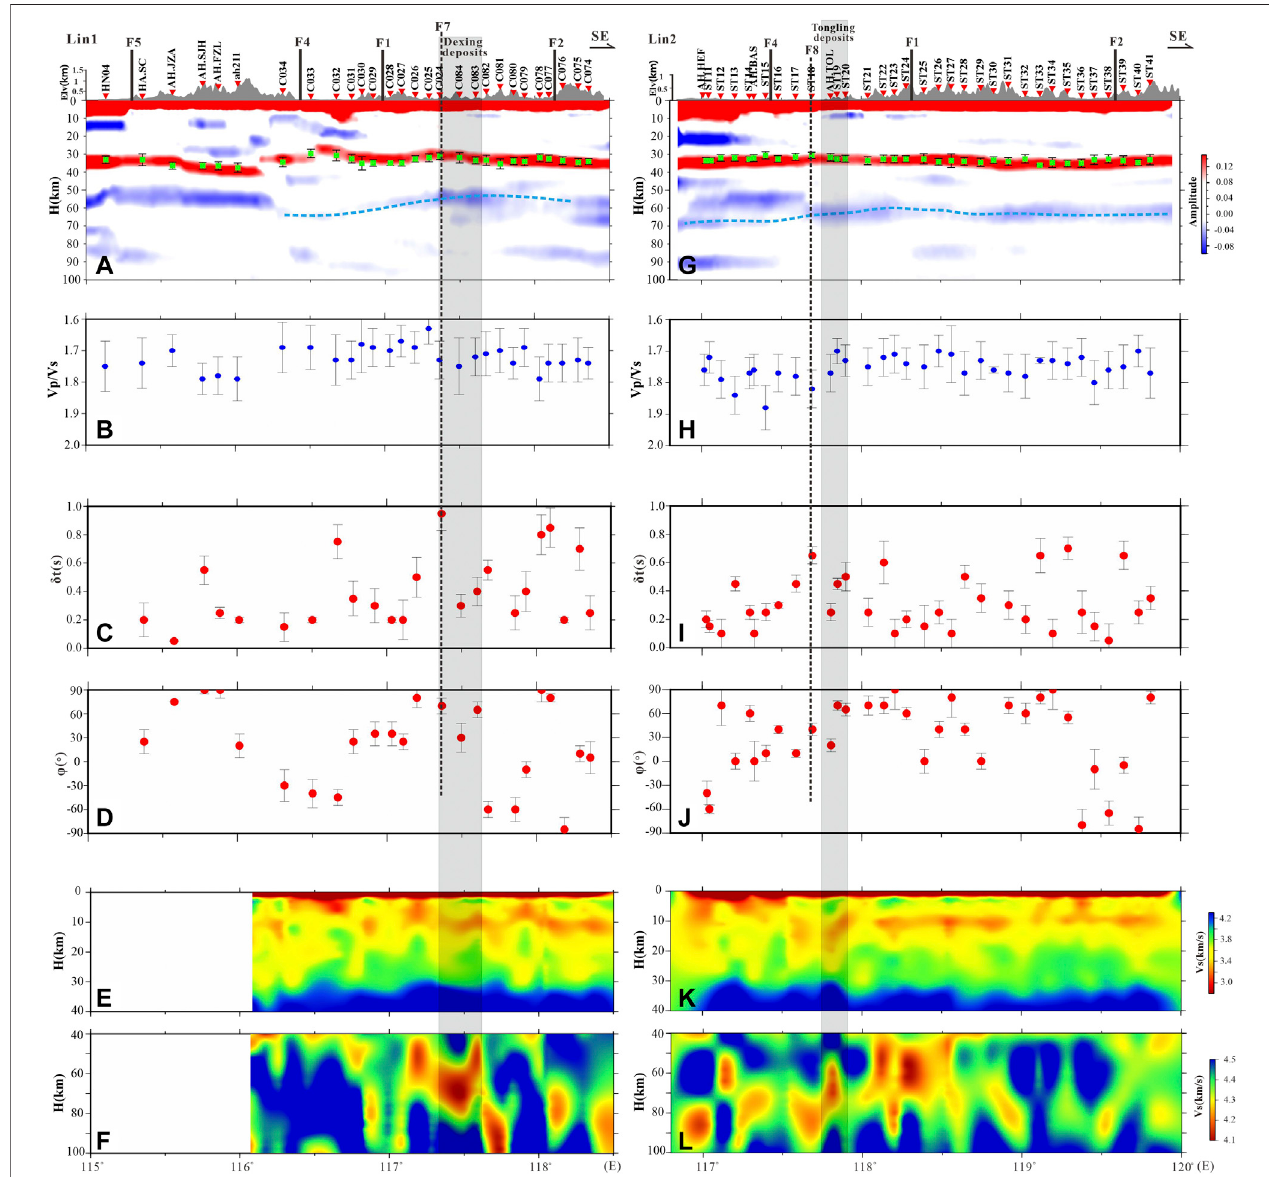
FIGURE 7 | Migration cross sections of “ Line 1 ” (A) and “ Line 2 ” (G) of CCP stacking, where the light blue dotted lines denote the location of LAB, and the green squares and error bars correspond to the single station H- κ -c results; Vp/Vs ratio (B,H) and associated errors; anisotropic parameters ( δ t, φ ) (C,D,I,J) and associated errors. We subtracted 180 ° if φ was > 90 ° , so that the range of φ was ( − 90 ° , 90 ° ); velocity structure (E,F,K,L) of nonlinear joint inversion (Ye et al., 2019). Station location andtopographyalongthepro fi leareshownonthetop.Grayshadinginthebackgroundindicatesthedifferentmetallogenicareas,andtheblackdashedlinesshow the positions of the northeast Jiangxi fault (F7) and the Yangtze River Deep Fault (F8) in the sections. Labels are the same as for Figure 1 .